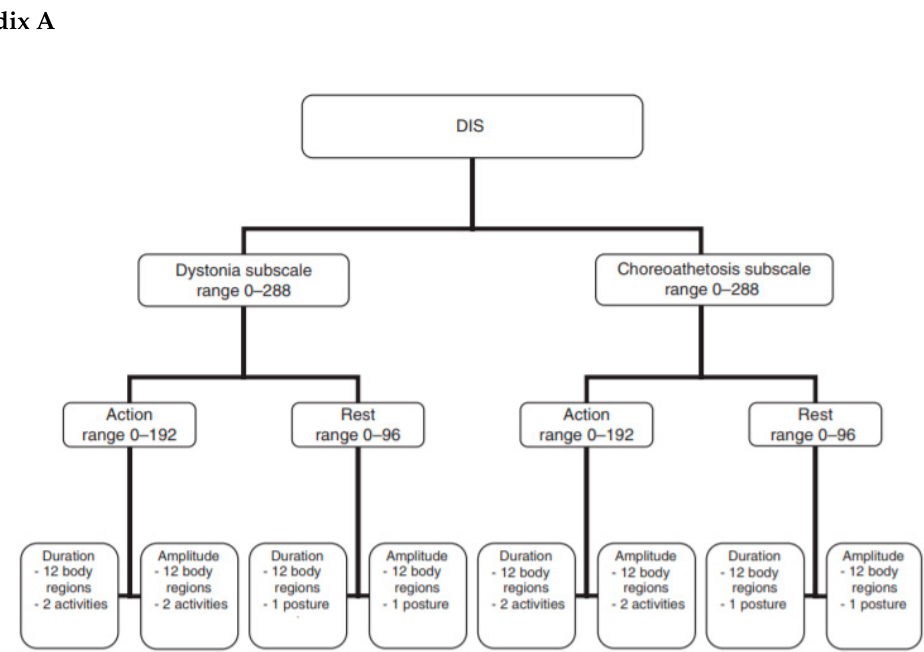
Figure 1. Diagram of the Dyskinesia Impairment Scale (DIS) protocol.